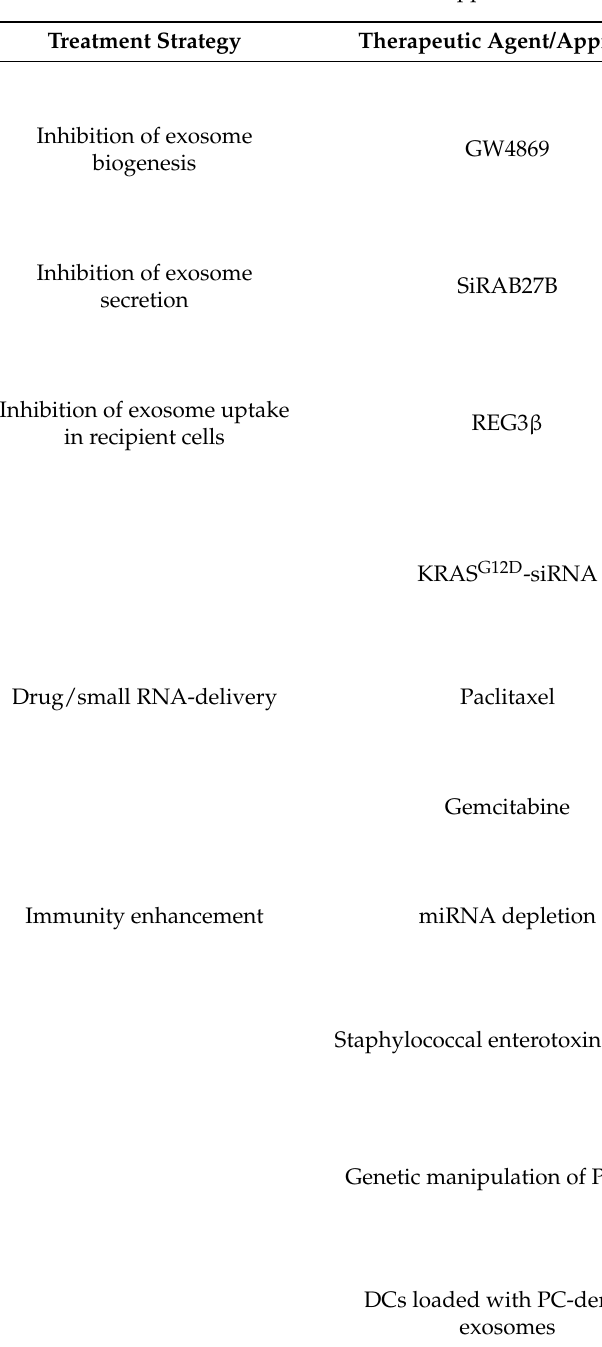
Table 3. Potential applications of exosomes in pancreatic cancer